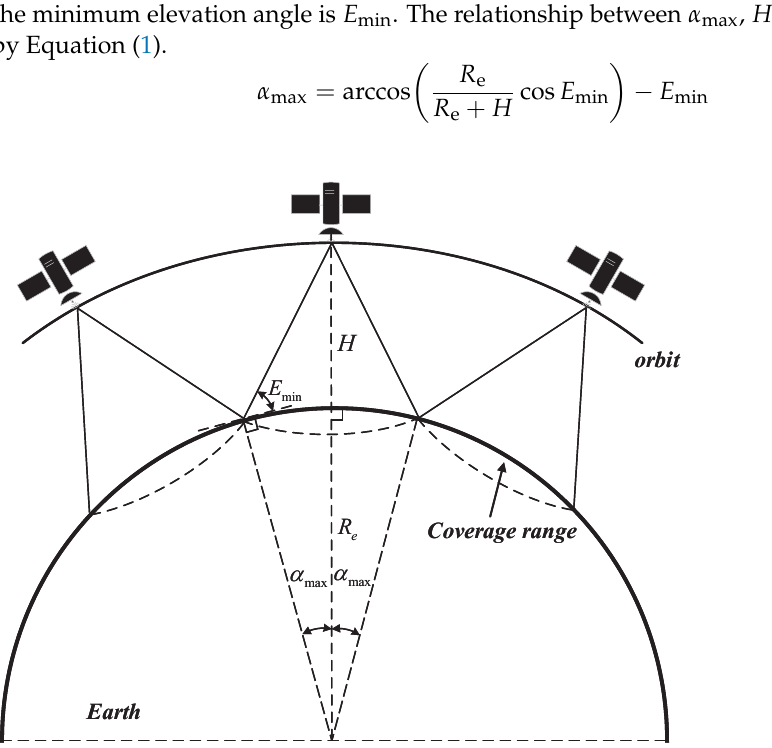
Figure 1. Satellite coverage